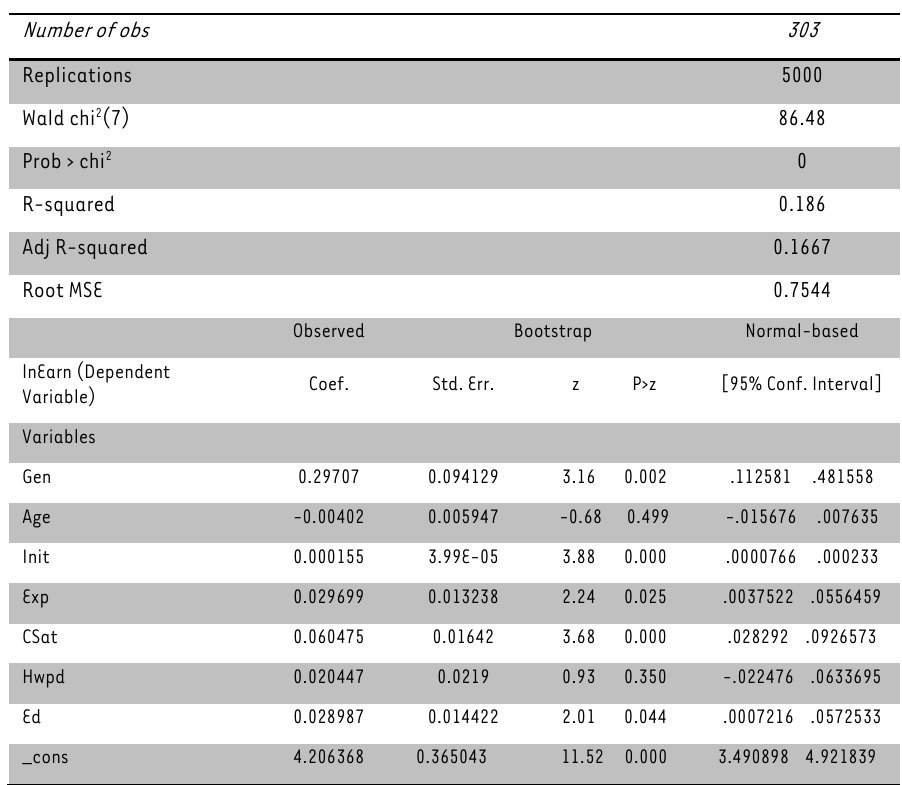
TABLE 3: The Regression Results: Covariates